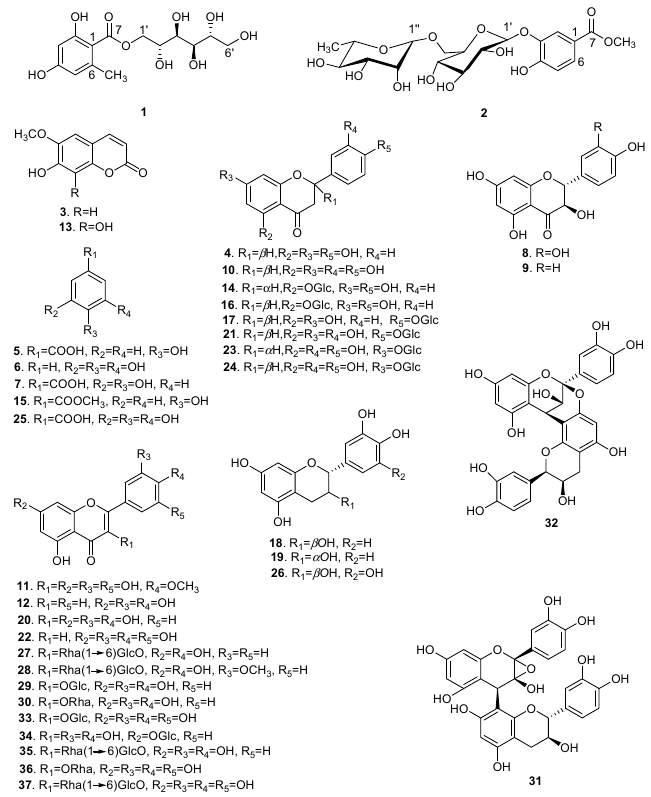
Figure 1. The chemical structures of polyphenols isolated from X. sorbifolia husks.